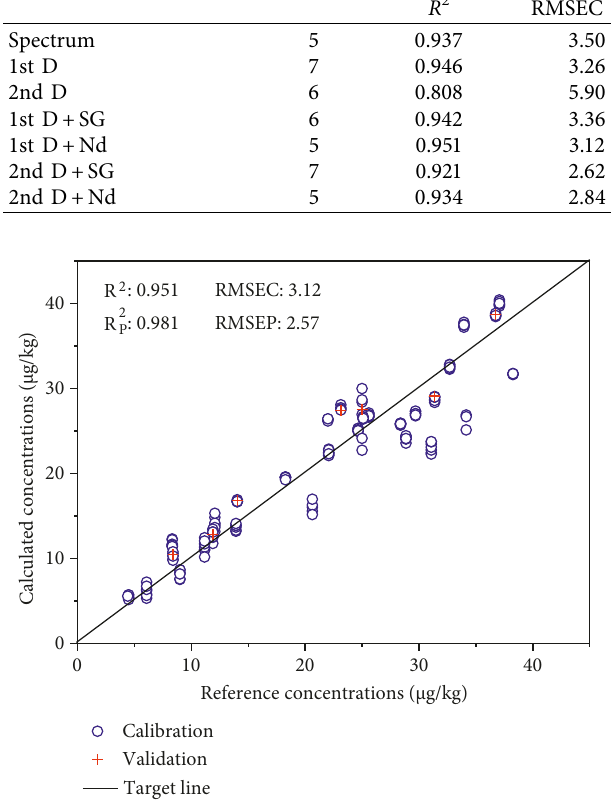
Figure 9: Correlation between reference and calculated concen- trations of AFB 1 .